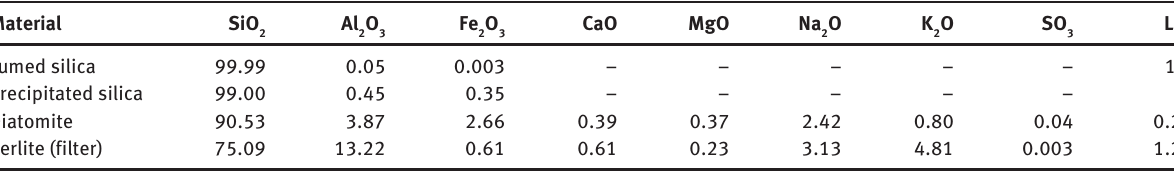
Table 4 Chemical properties of powder filling material.